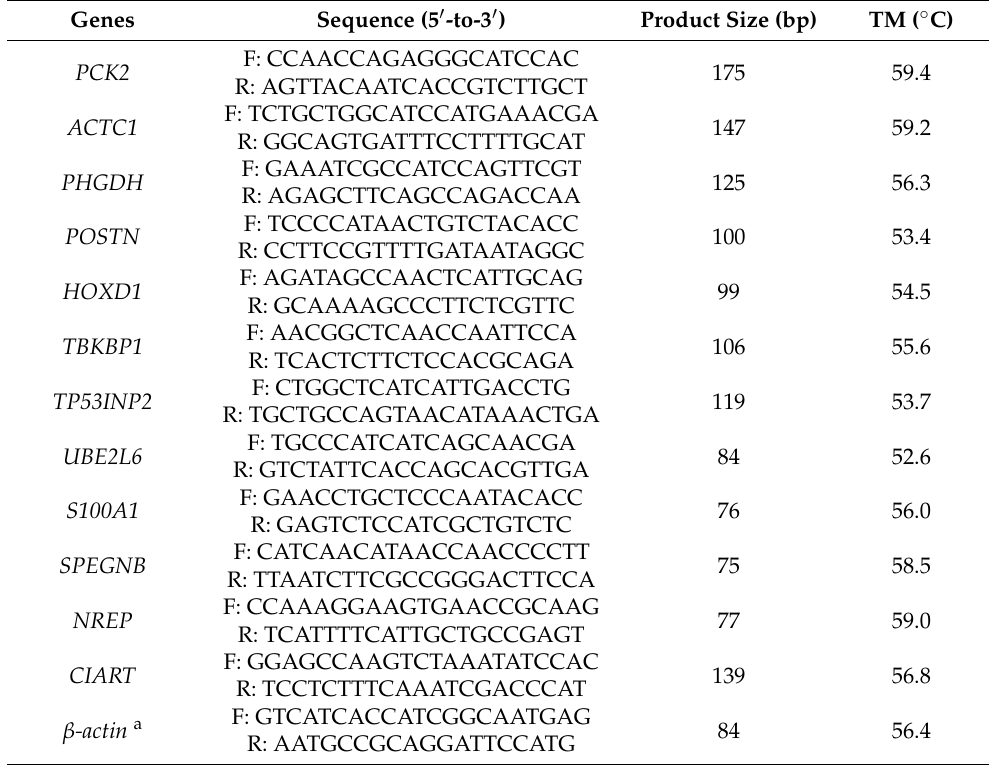
Table 1. Primers used in qPCR for twelve